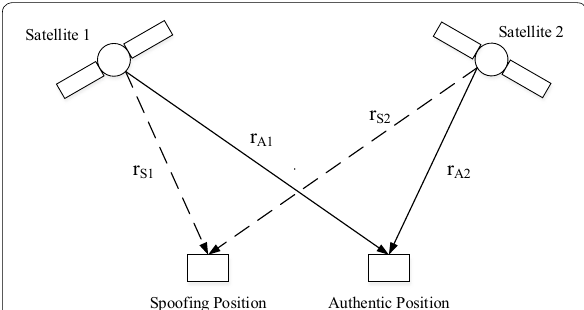
Fig. 1 Measurements grouping problem of spoofing and authentic